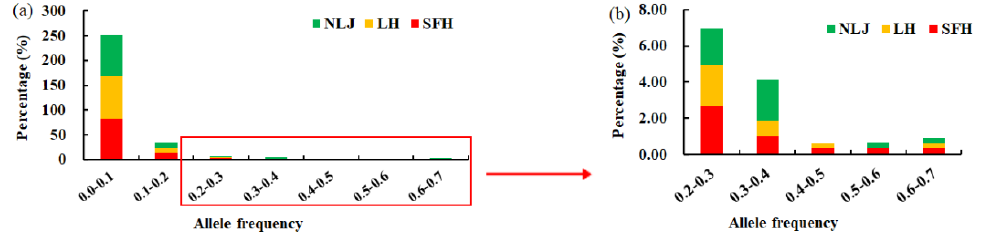
Figure 3. Allele frequency distribution of Eriocheir s. s. populations. ( a ) The percentage contents of 0.0–0.7 allele frequency distribution; ( b ) the percentage contents of 0.2–0.7 allele frequency distribution. Green, yellow, and red colors represent the Nanliujiang River (NLJ), Liaohe River (LH), and Suifenhe River (SFH) populations, respectively.